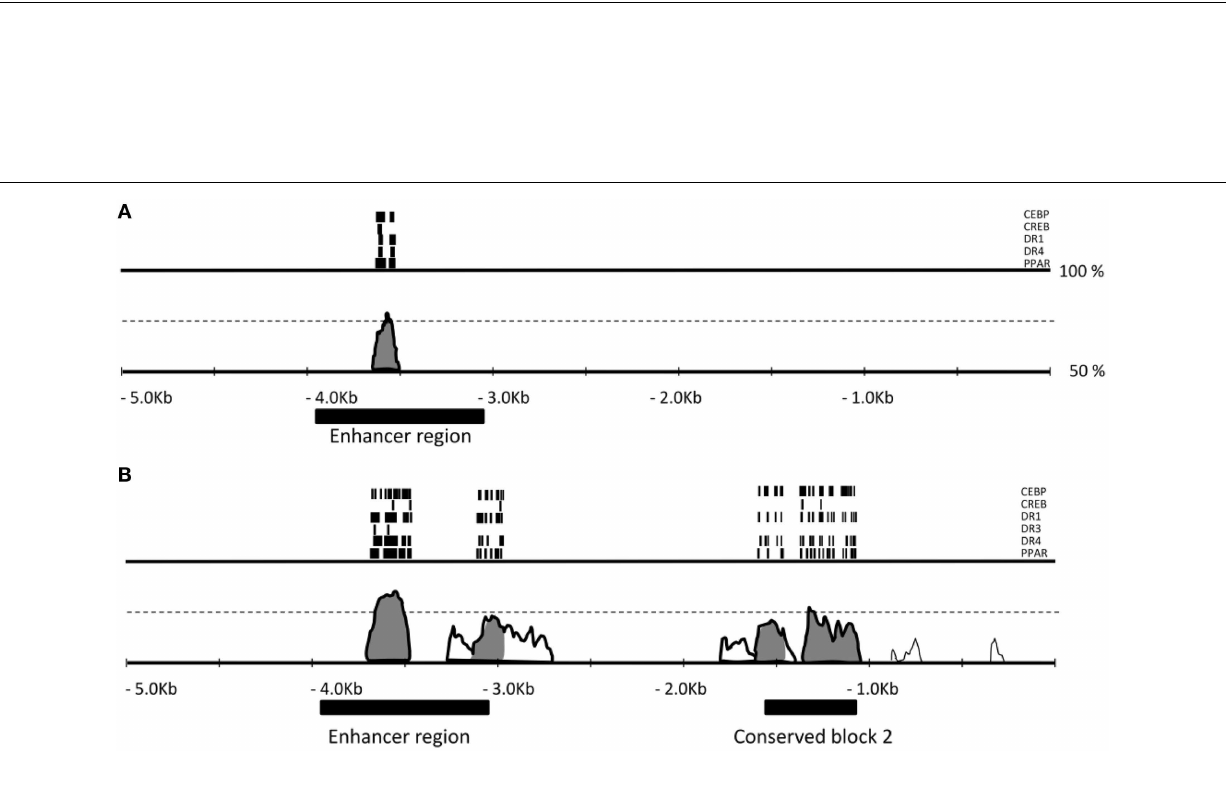
FIGUREA2 | Evolutionary conservation of the regions of the UCP1 5 (cid:48) UTR enhancer and putative regulatory region. Pairwise comparison of cow-mouse (A) and cow-human (B) genomic DNA 5Kb upstream of UCP1 gene rVISTA (Loots et al., 2002) using the AVID alignment algorithm (Bray et al., 2003). Conserved regions ( > 70% conserved in 100bp window are shaded). A highly conserved peak is